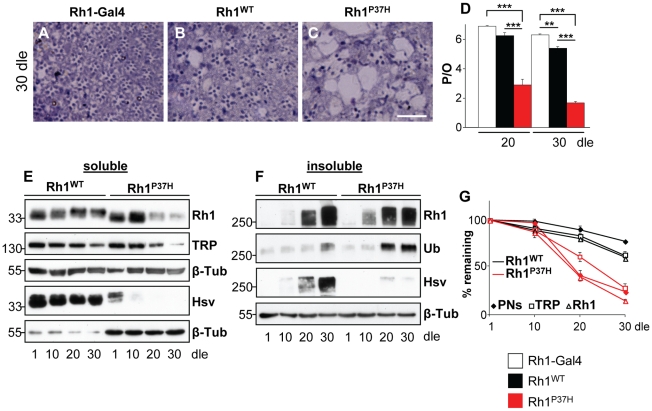
Progressive retinal degeneration and Rh1 loss in Rh1P37H-expressing flies exposed to light.(A–C) Photomicrographs of toluidine blue stained semithin eye sections of Rh1-Gal4 (A), Rh1WT;Rh1+/+ (B) and Rh1P37H;Rh1+/+ (C) flies kept in light for 30 days. Dle: days of light exposure. Scale bar is 50 µm. (D) Quantification of average number of photoreceptors/ommatidium (P/O) in different mutant groups (n>7 animals in each group, **p<0.01 and *** p<0.001 t-test). Rh1P37H;Rh1+/+ flies display a dramatic loss of P/O after 20 dle. (E,F) Immunoblots revealing the abundance of total (endogenous and ectopic, Rh1 antibody) and ectopic (hsv antibody) Rh1 in detergent-soluble (E) or insoluble (F) fractions obtained from retinas of Rh1WT;Rh1+/+ or Rh1P37H;Rh1+/+ flies exposed to light for the indicated durations. The rhabdomeric marker TRP was used to independently assess rhabdomere loss (E) while aggregates were independently labeled with an Ubiquitin antibody (F). β-Tubulin (β-Tub) served as loading control. Please note that 5-fold less protein (E) was loaded for Rh1WT;Rh1+/+ flies for the hsv WB. (G) Graph describing the changes of mature Rh1 levels (triangles), TRP levels (squares) and retinal degeneration (P/O; rhombus) in Rh1WT;Rh1+/+ and Rh1P37H;Rh1+/+ flies exposed to light for increasing durations.